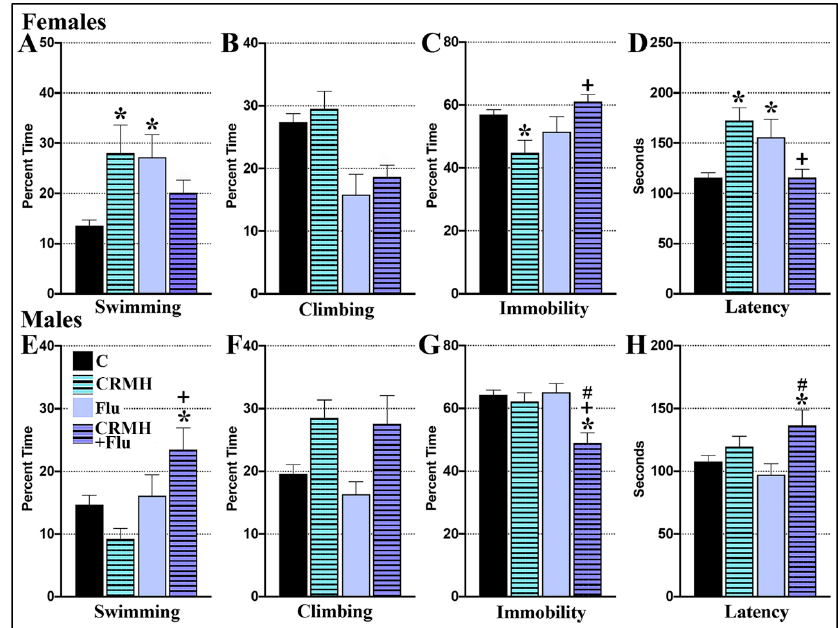
Figure 8. Dietary CRMH improves efficacy of the SSRI fluoxetine in male rats at altitude but not females. In females at altitude, CRMH + FLU did not significantly improve ( A ). swimming or ( B ). climbing behavior, and ( C ). significantly increased immobility and ( D ). decreased LTI vs. controls. In males at altitude, CRMH + FLU significantly ( E ). increased swimming, ( F ). did not significantly alter climbing, ( G ). decreased immobility and ( H ). increased LTI vs. controls (two-way ANOVA, * = p < 0.05 vs. food controls, + = p < 0.05 vs. dietary CR, # = p < 0.05 vs. FLU).